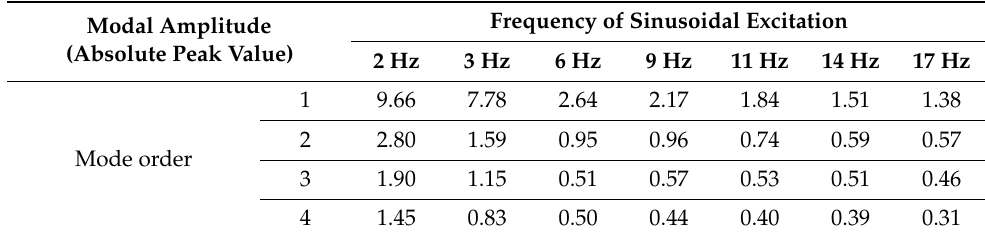
Table 8. Amplitude responses of vibration modes under different input